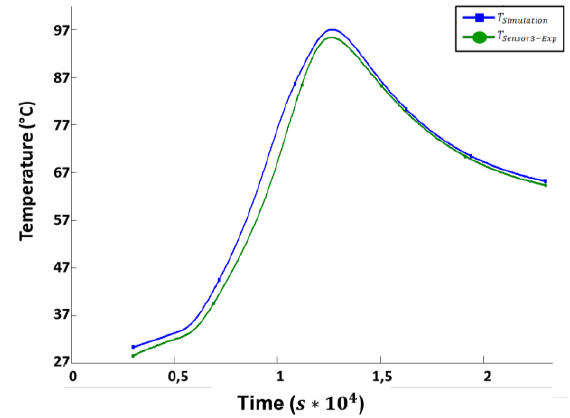
Figure 11. Comparison between simulated and measured data for sensor 3.